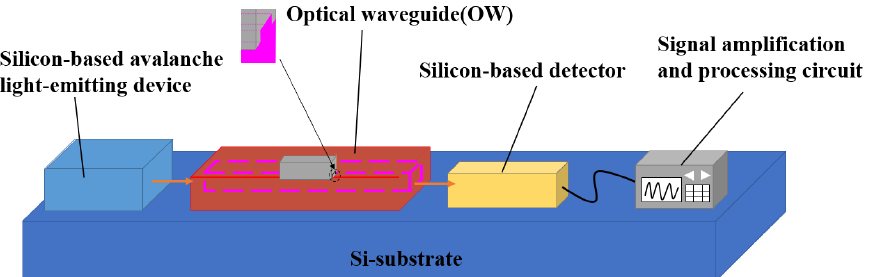
Figure 1. In ASPB, the light generated by the silicon-based avalanche light-emitting device was transmitted to the OW and coupled with the material to be detected, resulting in light attenuation. Then, the attenuated light was detected by the silicon-based detector and converted into an electrical signal. Finally, the sensing results were output by the processing circuit.